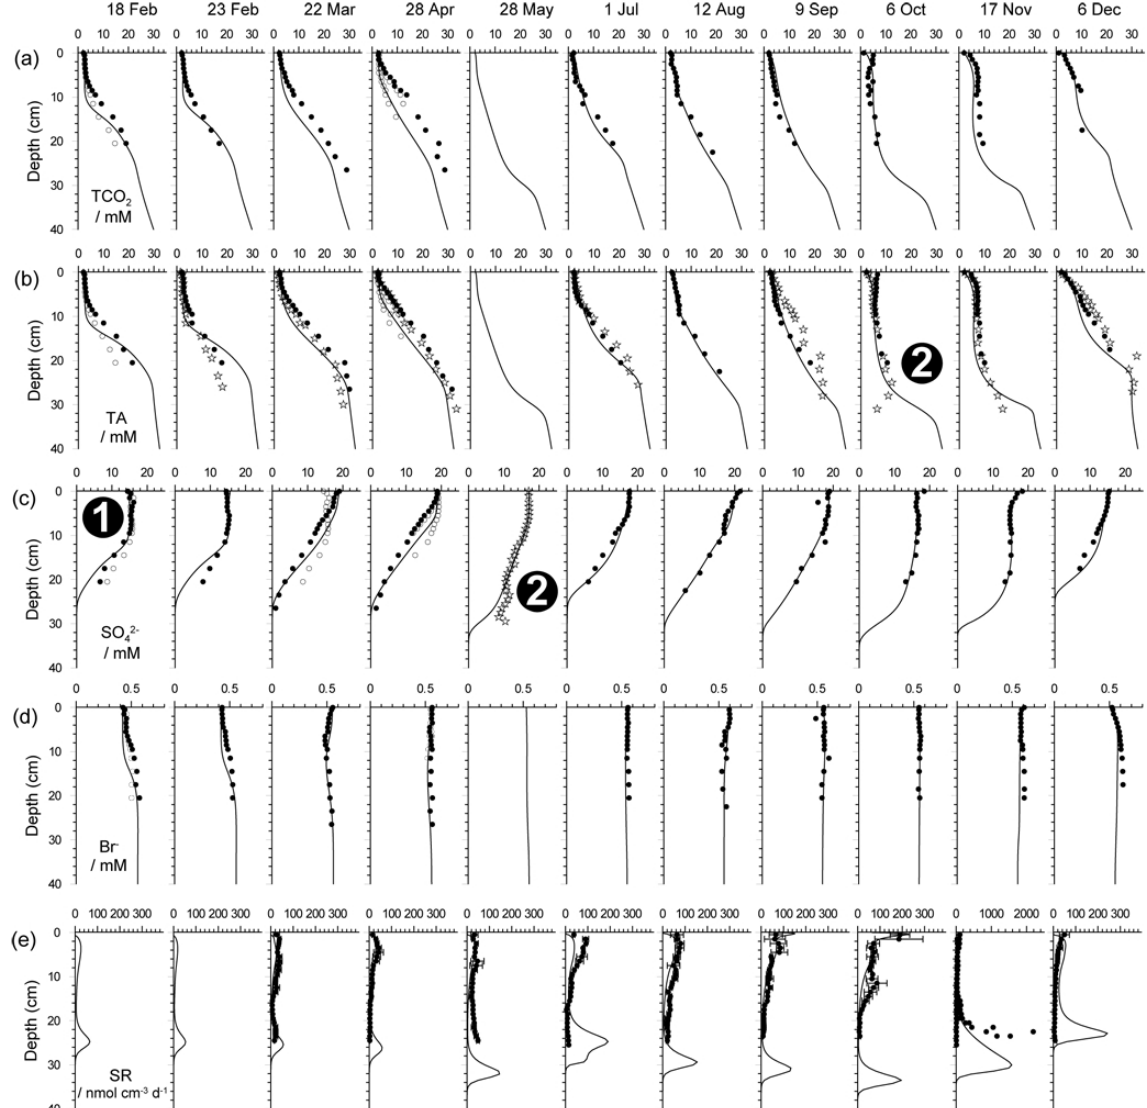
Fig. 4. Simulated (curves) and measured (symbols) geochemical concentrations and SR rates in Boknis Eck sediments sampled on the dates indicated at the top of the figure. Open and closed circles indicate porewater measurements from adjacent multi-cores sampled by squeezing the sediments. Stars indicate porewater extracted by rhizons. The error bars in (e) indicate the standard deviation of 3 replicate SR rates sampled from the same core. SR rates in November are shown for the individual triplicate cores to highlight the very high rates measured in two of the sub-cores (note the change in scale). The modeled SR is the sum of sulfate consumption by organic carbon and methane + R oxidation (0.5 × R SO AOM ). The numbers 1 to 3 in black circles highlight examples of the salient seasonal features (1 4 concentrations in the upper 10cm in winter, 2 = weakening of the concentration gradients in May and October/November, and 3 = the Fe 2 + and TPO 4 peaks in winter and autumn). For an explanation of the dashed curves in ( g ) see Sect.